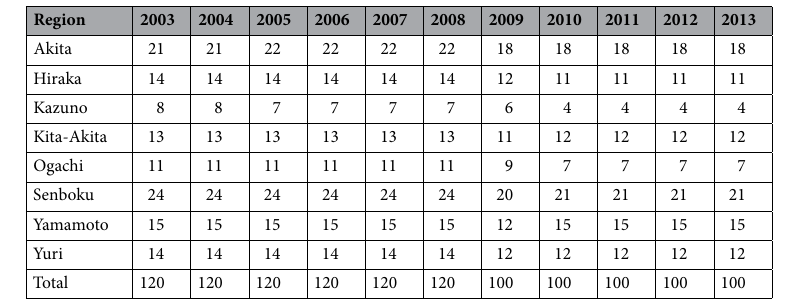
Table 1. Monitoring points for rice phenology in each region in each